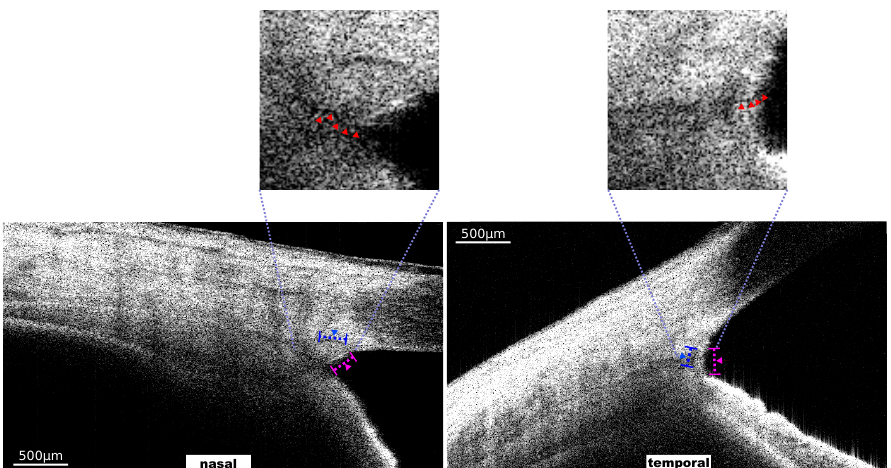
Figure 6. Contrast OCT structural images for subfigures (i) and (ii) of Figure 5. The trabecular meshwork (TM) and Schlemm’s canal (SC) are marked by the pink and blue dashed lines, respectively. In the enlarged view of the TM-SC region, a microtubule structure is marked by the red arrows.